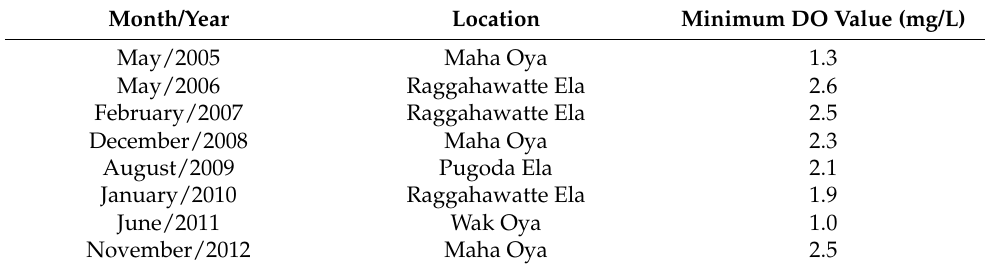
Table 2. Minimum DO values along the Kelani River.